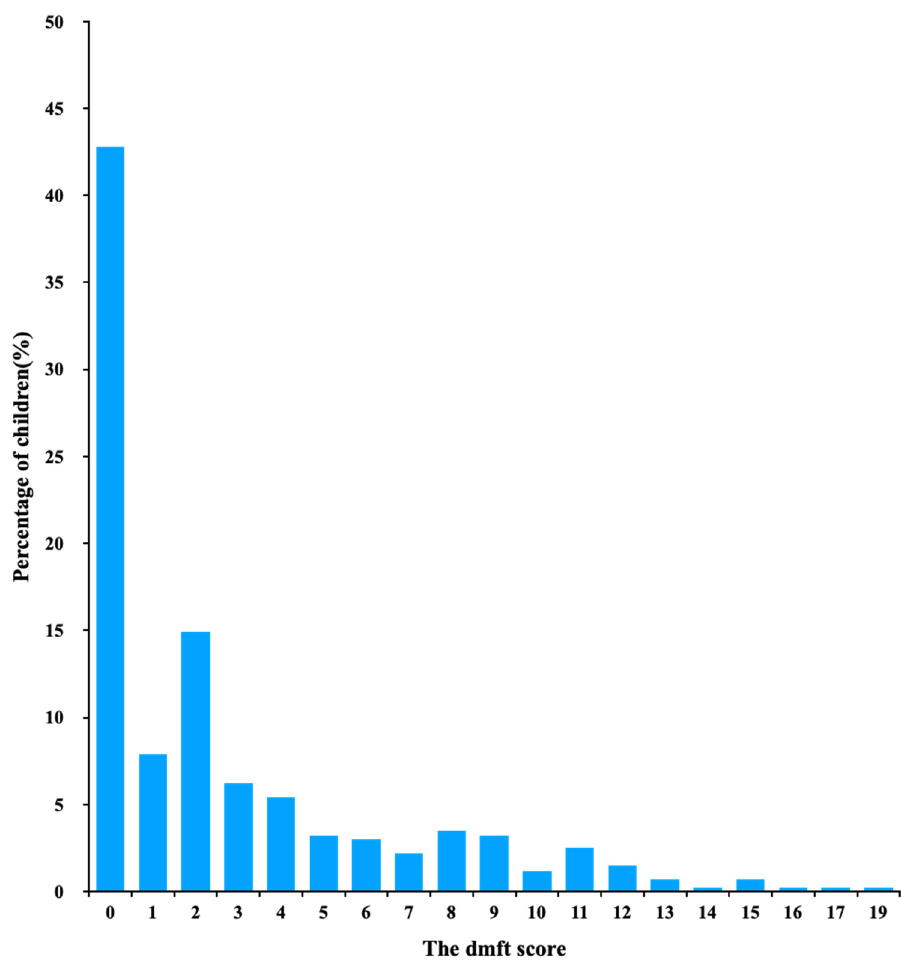
Figure 1. Untreated ECC index (dt) of 5-year-old children in Hong Kong ( n =